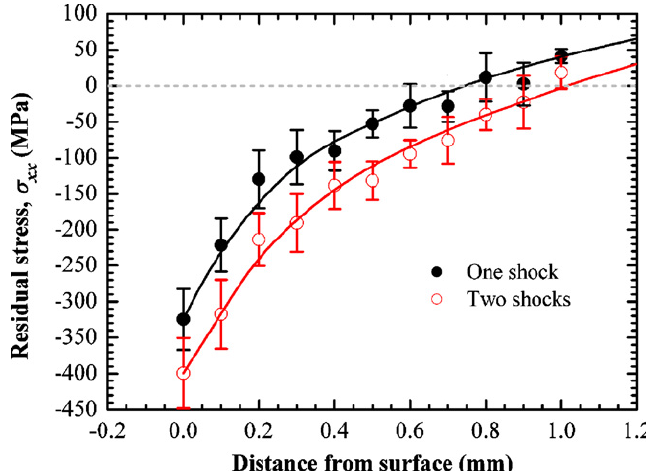
Figure 7. Residual stress profiles induced by one and two shocks using 40% overlapped spots on Ti-6Al-4V